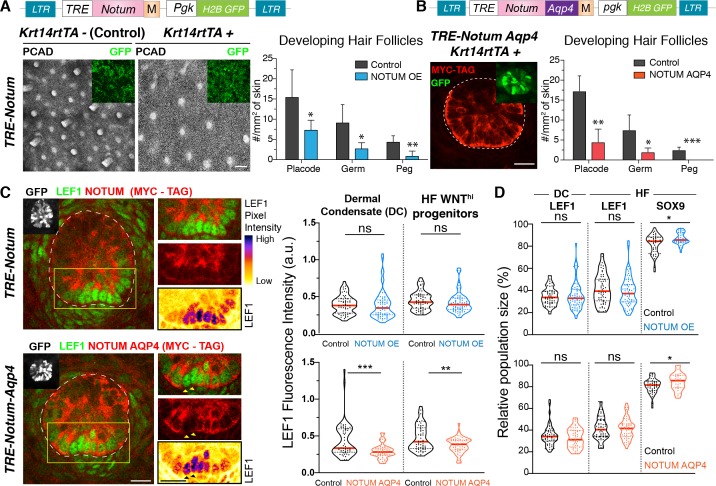
Hair bud progenitors apically polarize WNT inhibitors to protect their own identity and differentially confer WNT signaling to their neighbors.(A) Whole-mount immunofluorescence and quantifications reveal that elevating NOTUM across the epidermal plane results in significantly fewer hair follicles (Mean ± SD; n > 10 mm2 skin analyzed from ≥3 embryos; *p<0.05; **p<0.005; Mann-Whitney test). Scale Bar, 100 μm. OE, overexpression. Insets verify transduced regions. All scale bars for immunofluorescence images are 20 μm. (B) Adding an aquaporin4-tag mispolarizes NOTUM to the basal side of hair bud progenitors. Quantifications reveal that mis-polarizing a WNT inhibitor poses a significant impediment to hair follicle morphogenesis (Mean ± SD; n = 8 mm2 skin analyzed from ≥3 embryos; *p<0.05; **p<0.005; ***p<0.0005; unpaired Student t test). White dotted lines demarcate epithelial-mesenchymal borders throughout. (C) Whole-mount immunofluorescence and quantifications of normalized LEF1 pixel intensities reveals that NOTUM mis-polarization leads to a significant decrease of LEF1 intensity in WNT signaling cells from both the dermal condensate and the hair bud (n ≥ 48 hair follicles from ≥3 embryos each; Mann-Whitney test ***p=0.0002 and unpaired t test **p<0.005; n.s. non-significant; red lines represent the distributions’ median). Yellow boxes show regions magnified at right. Arrowheads show two cells not expressing NOTUM-AQP4-MYC-Tag, which have higher LEF1 signal than their expressing neighbors. (D) Violin Plots show that increasing levels of NOTUM and NOTUM-AQP4 lead to an increase of SOX9 expressing cells (n ≥ 30 developing hair follicle from at least three different embryos; Mann-Whitney test TRE-NOTUM *p=0.0389 and TRE-NOTUM-AQP4 *p=0.0461 n.s. non-significant; red lines represent the distributions’ median).Figure 6—source data 1.Source data for the graphs shown in Figure 6A, B, C, and D.